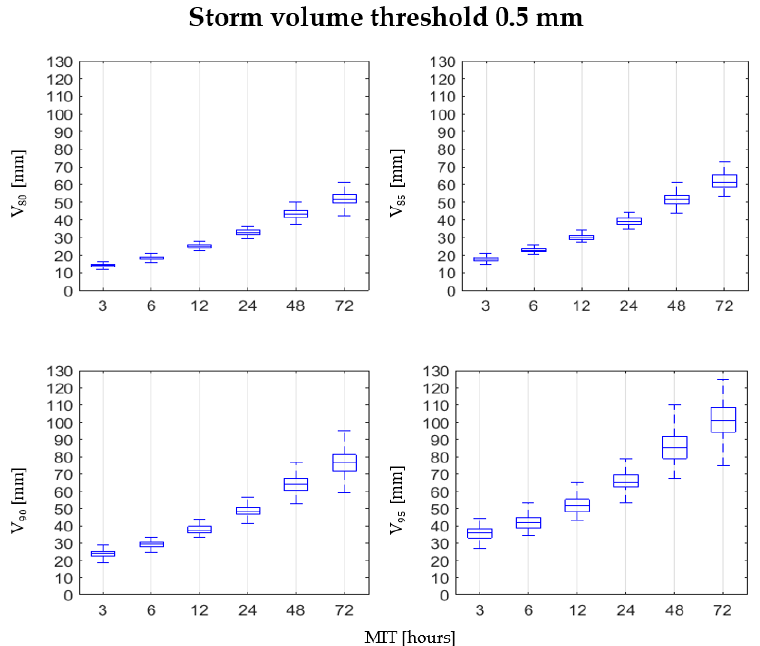
Figure 9. Effect of different MITs on volumetric percentiles that treat a percentage of the total volume of accumulated rainfall series, for simulated rainfall series and a fixed 0.5 mm value of storm volume threshold.